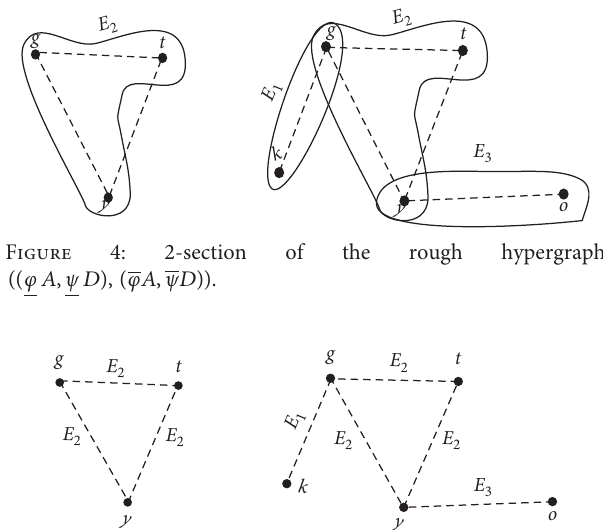
Figure 5: L2-section of rough hypergraph (( φ A, ψ D ) , ( φ A, ψ D ))